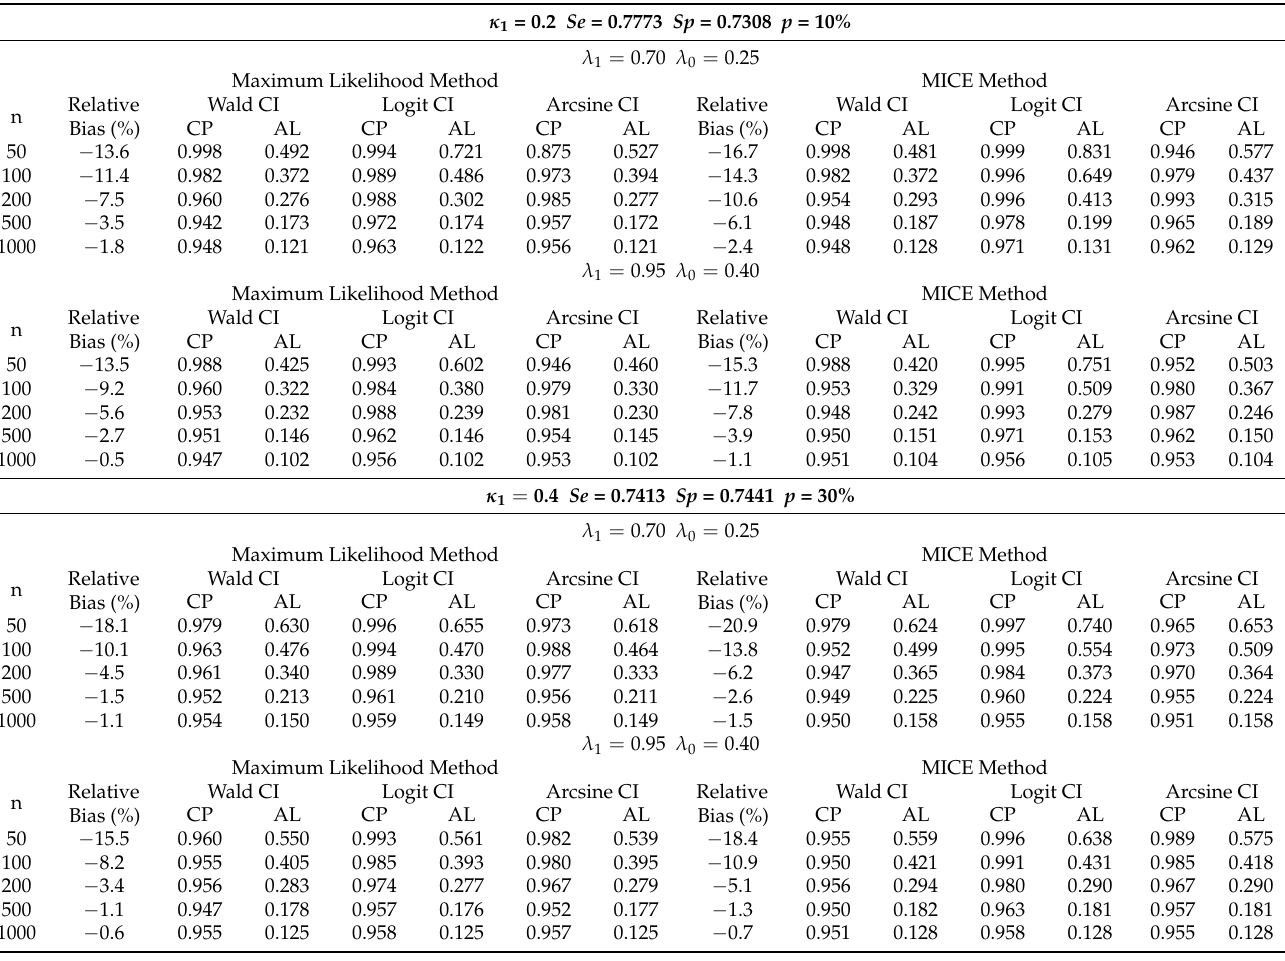
Table 3. Coverage probabilities and average lengths of CIs for κ 1 = { 0.2,0.4 }